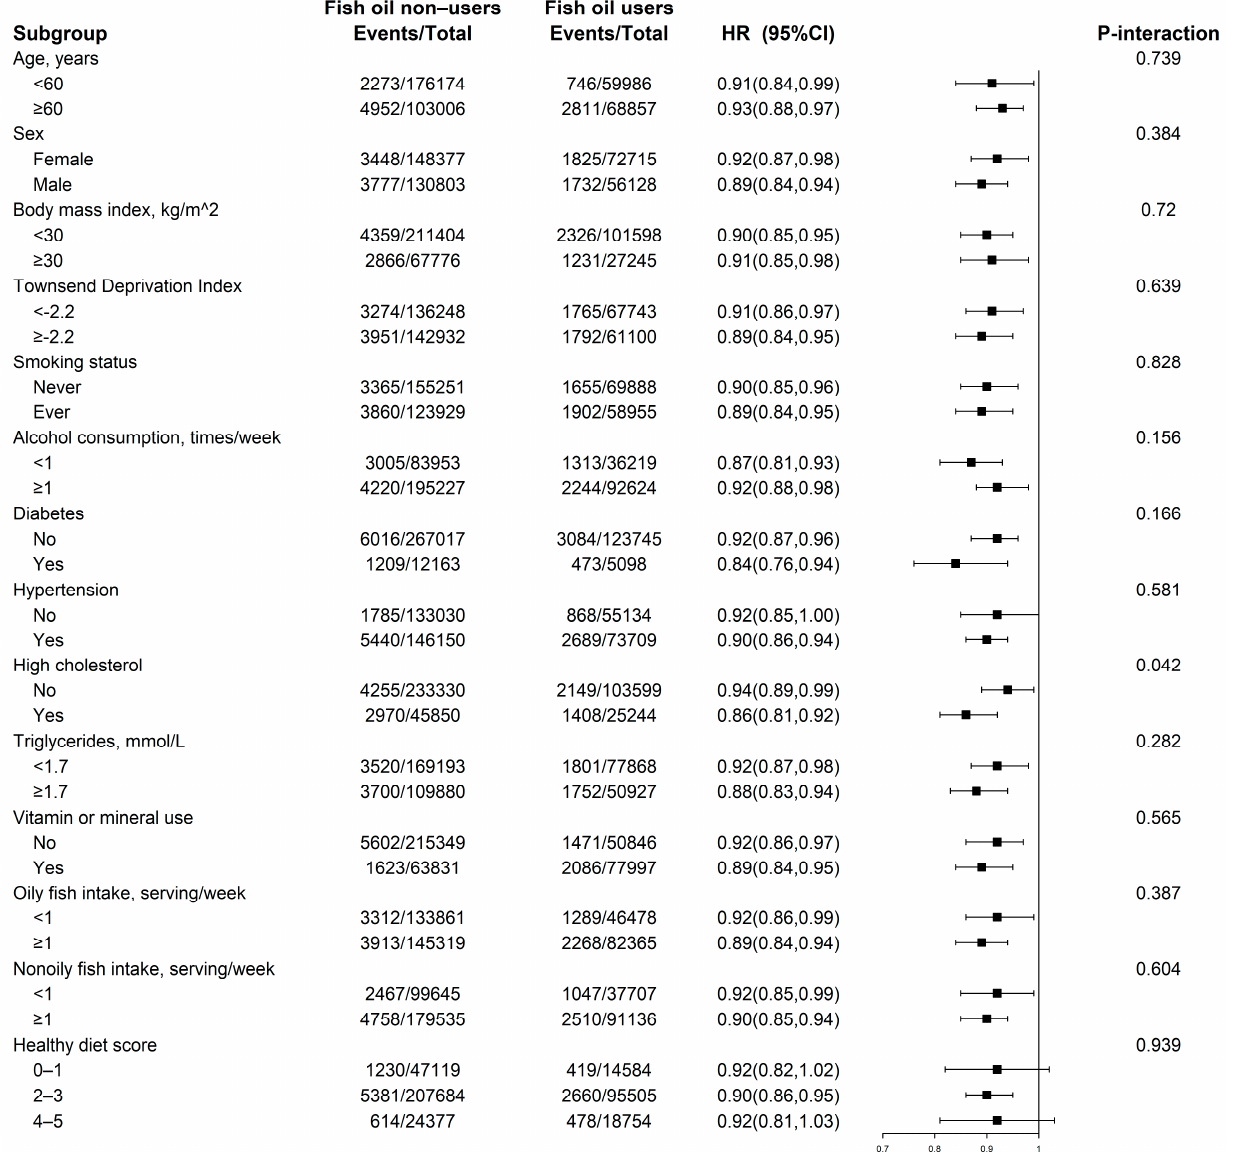
Figure 2. Association of fish oil supplement use and the risk of chronic kidney disease stratified by potential risk factors. Results were adjusted for age, sex, race, Townsend Deprivation Index, body mass index, smoking status, alcohol consumption, diabetes, hypertension, high cholesterol, vitamin or mineral supplementation, healthy diet score, estimated glomerular filtration rate, urine albumin: creatinine ratio, oily fish intake, and nonoily fish intake, if not already stratified.